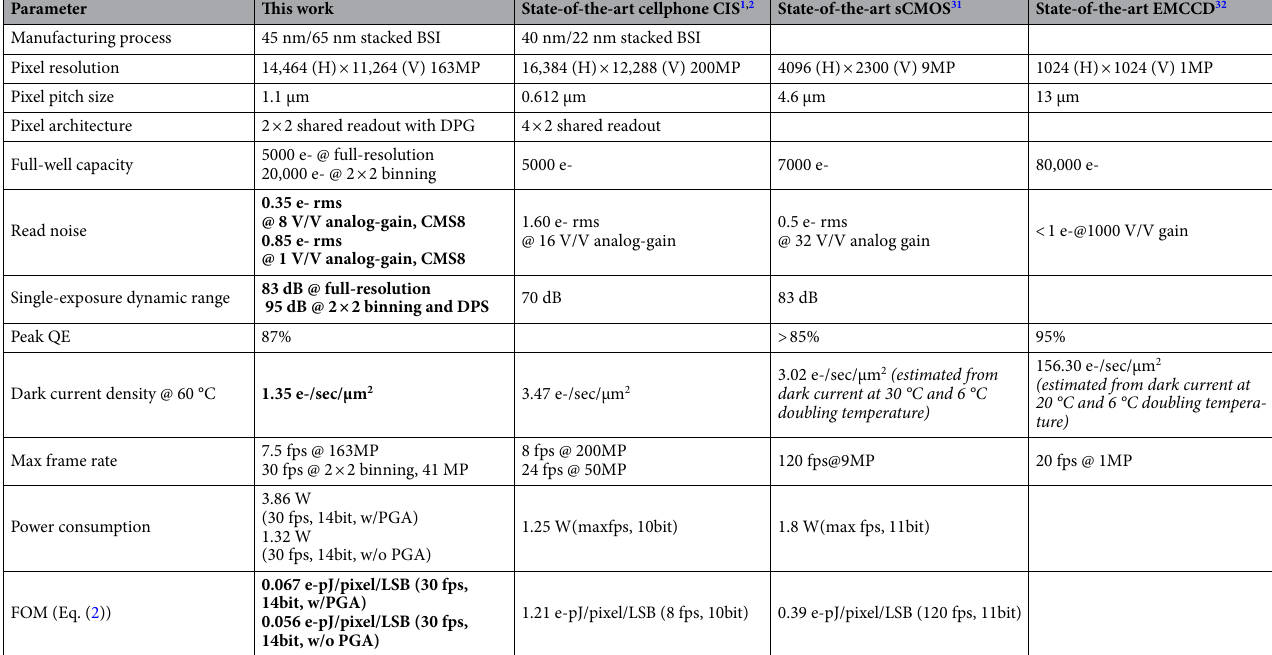
Table 1. Performance summary and comparison with the state-of-the-art image sensors. Significant values are in